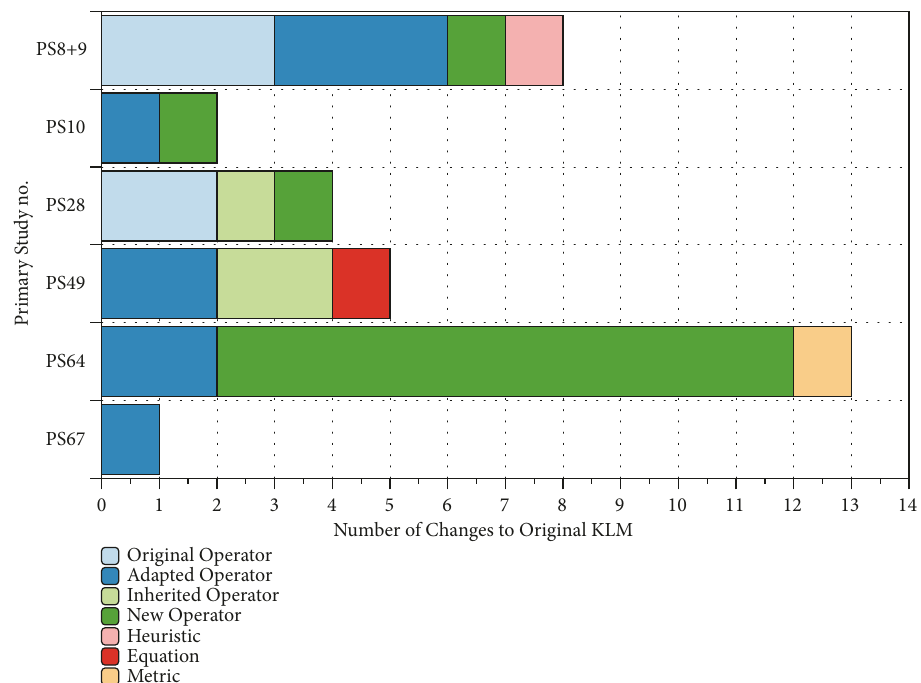
Figure 13: The number of original operators preserved, adapted, inherited from other extension or literature, and newly introduced in the specialised setup